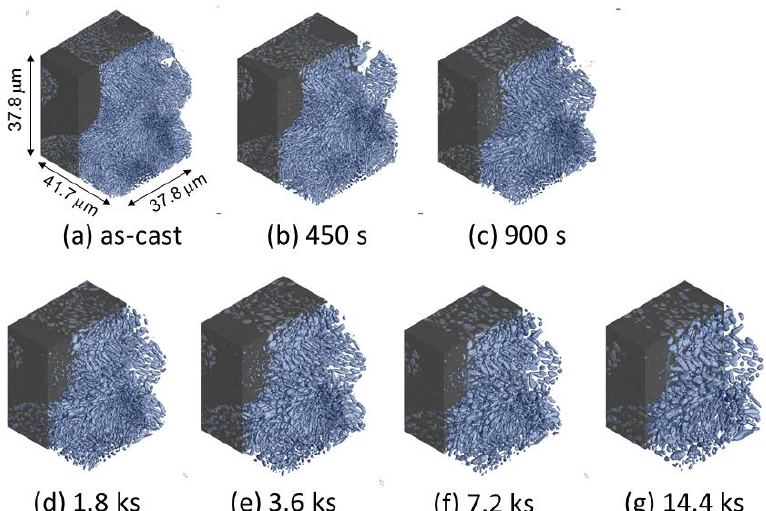
Figure 7. Three-dimensional volume images of eutectic Si-particles in Al-10.1%Si-4ppmP-108ppmSr cast alloy. ( a ) As-cast, ( b ) heat-treated at 773 K for 450 s, ( c ) heat-treated at 773 K for 900 s, ( d ) heat-treated at 773 K for 1.8 ks, ( e ) heat-treated at 773 K for 3.6 ks, ( f ) heat-treated at 773 K for 7.2 ks, ( g ) heat-treated at 773 K for 14.4 ks.